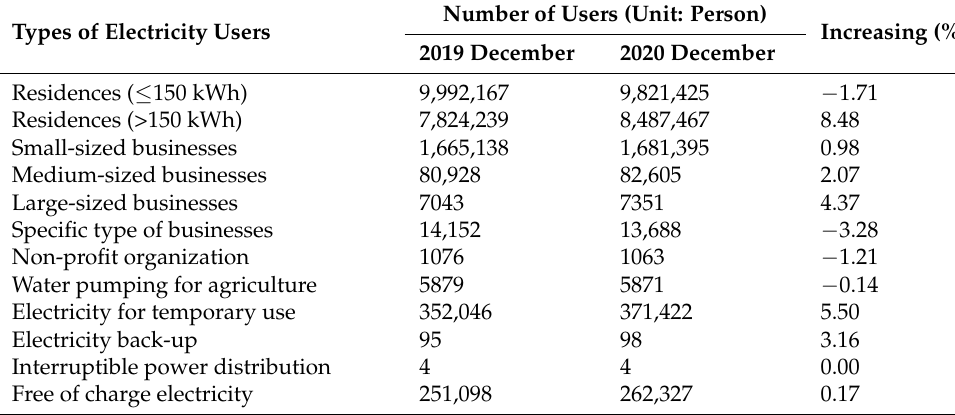
Table 4. Number of PEA electricity